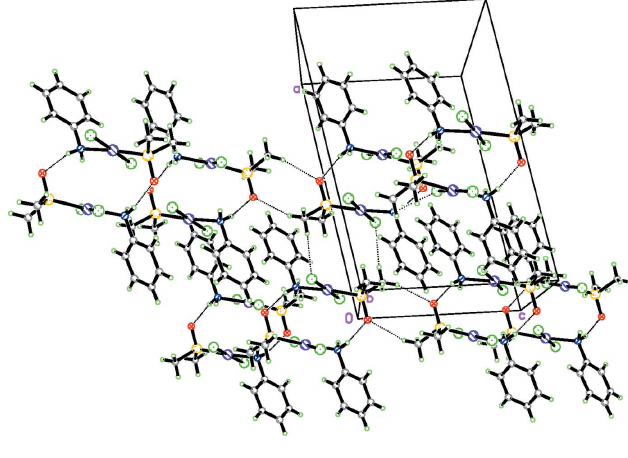
Figure 3 Overall packing of the title compound viewed along the b -axis direction.